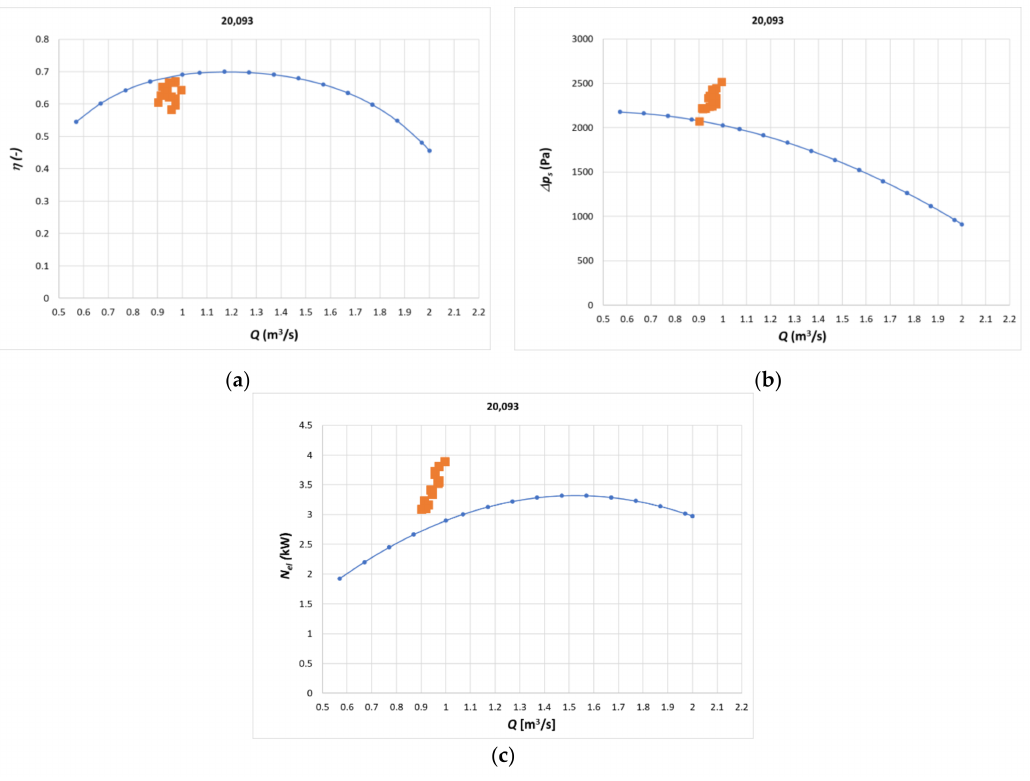
Figure 2. Selected measurement results in the period from June to January 2022 against the back- ground of the characteristics of an exemplary 20,093 fan, where: ( a ) efficiency η as a function of flow Q , ( b ) pressure increase ∆ ps as a function of flow Q , ( c ) power Nel as a function of flow Q , blue line characteristic, orange